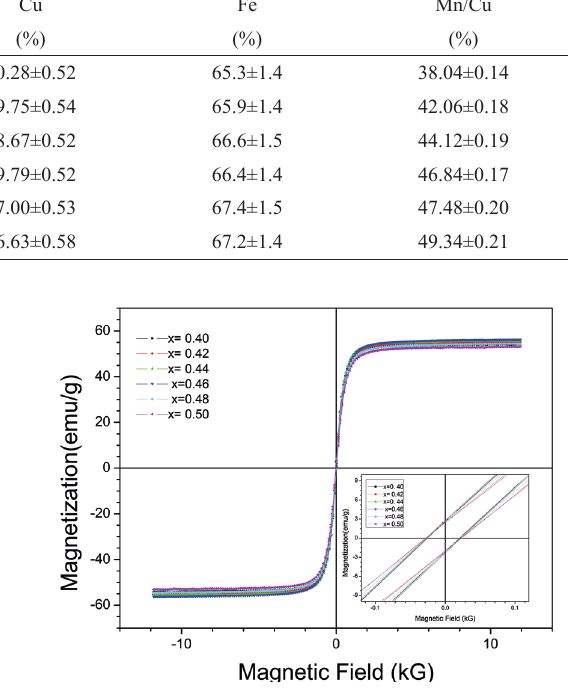
Figure 5: Hysteresis loops at room temperature of samples Mn Fe O . The inset corresponds to a zoom to help identifying the Cu Fe O . x 2 4 x 1-x 2 4 coercitive fields and remanent Cu Fe O x 1-x 2 4 the donor concentration and E the c b